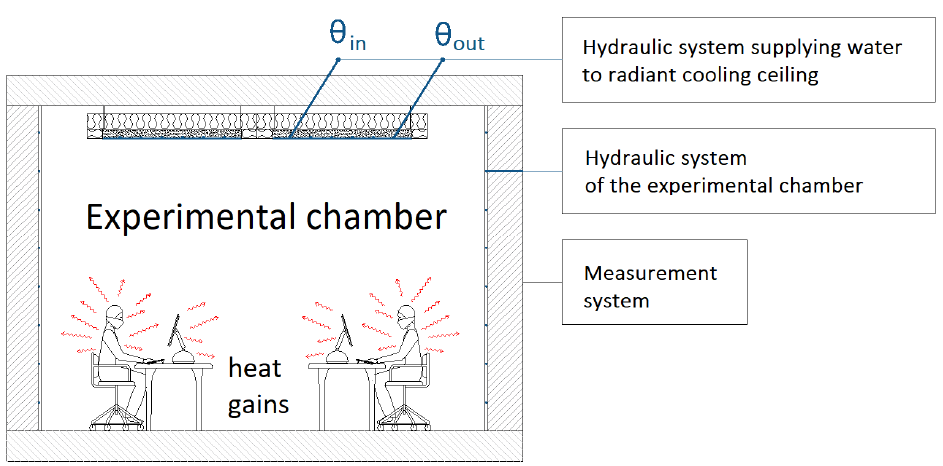
Figure 1. Structure of the test stand [42].